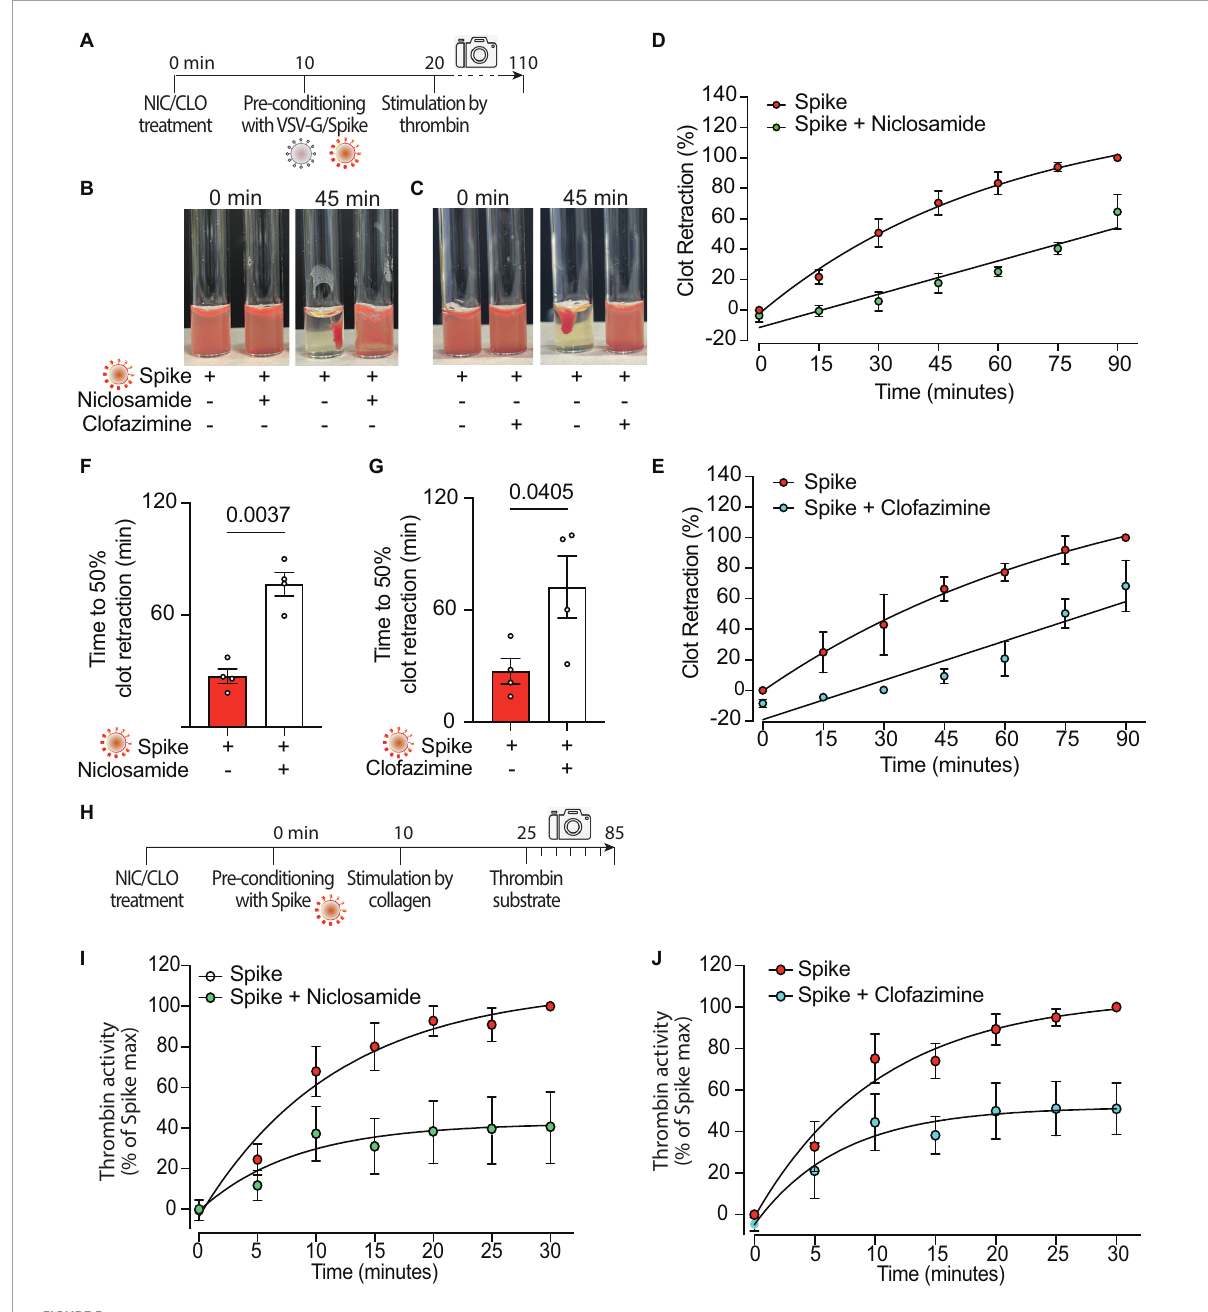
FIGURE5 Niclosamide and Clofazimine block procoagulant activation of platelets. (A) Experimental scheme to study the effect of drugs on the clot retraction assay following stimulation of platelets with Spike. PRP, supplemented with CaCl 2 and 10 µ l of whole blood, were incubated with Niclosamide or Clofazimine for 10 min, then treated with 1:10 diluted VSV-G or Spike pseudoparticles for additional 10 min. Clot retraction was measured over 90 min from the addition of thrombin, taking an image every 15 min. (B,C) Representative images of clot retraction when platelets were treated with Spike and either Niclosamide (B) or Clofazimine (C) , immediately after the addition of thrombin and after 45 min. (D,E) Percentage of clot retraction over 90 min, when platelets were treated with Spike and either Niclosamide (J) or Clofazimine (K) . Results are from n = 4 independent experiments. Data are expressed as mean ± SEM. (F,G) Time to 50% clot retraction when platelets were treated with Spike and either Niclosamide (L) or Clofazimine (M) . Results are from n = 4 independent experiments. Data are mean ± SEM. Statistical significance is shown (paired Student’s t -test). (H) Experimental scheme to study the effect of drugs on thrombin generation upon platelet treatment with Spike pseudovirions. PRP was incubated with 1:10 diluted VSV-G or Spike for 10 min at 37 ◦ C, followed by incubation with collagen (30 µ g/mL) for 15 min and the addition of a fluorogenic thrombin substrate. Thrombin activity was assessed by the measurement of the conversion of the thrombin substrate into its fluorogenic state. (I,J) Concentration of thrombin formed during a 30 min-time period in PRP treated with Spike and pre-conditioned or not with Niclosamide or Clofazimine. Data are expressed as mean ±